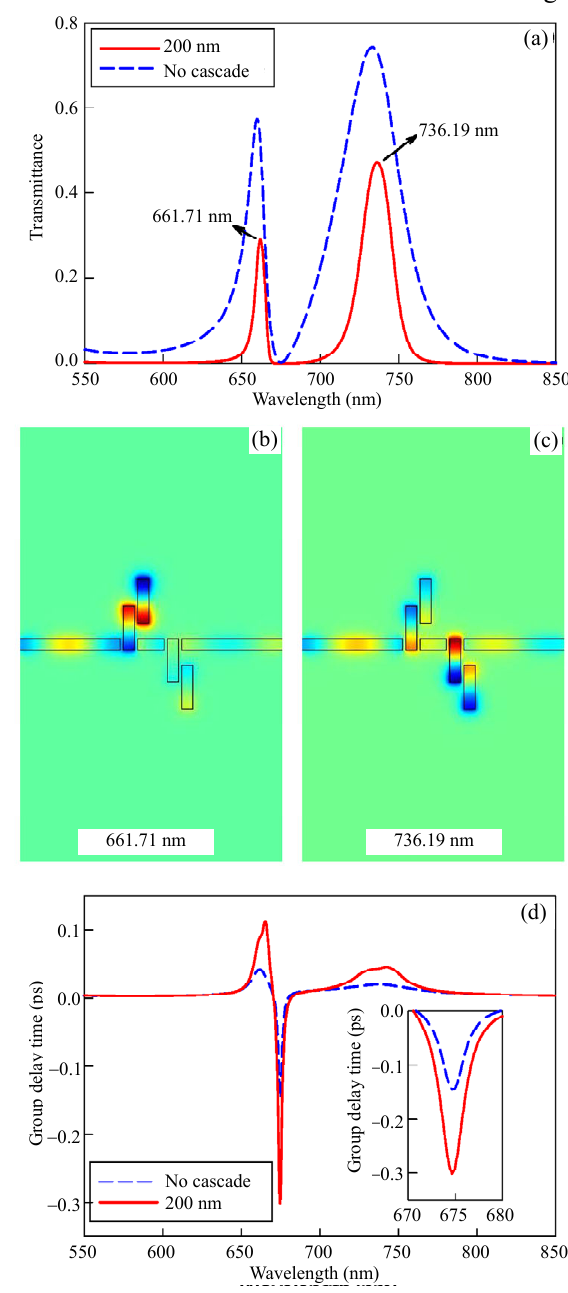
Fig. 4 Transmission spectrum (a) and group delay time (d) of the proposed cascade device. For convenience, corresponding results of the non-cascading device are also shown using blue-dashed line in these figures. (b), (c) Corresponding magnetic field distributions for the two resonance